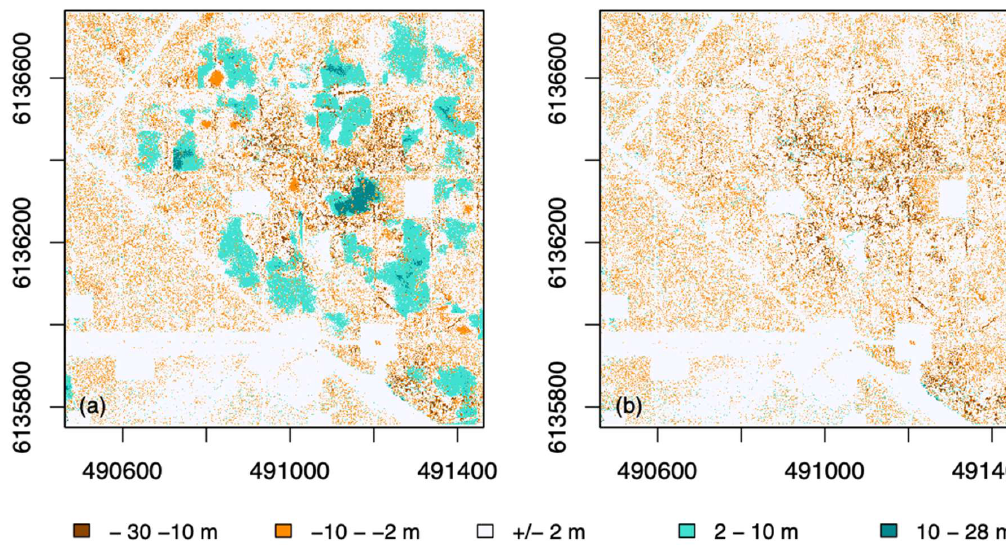
Figure 8. Differential images of: ( a ) CHM DAP and ( b ) CHM Hybrid , each compared to CHM LiDAR . (a) shows large clusters of high divergence from the CHM LiDAR , depicted in turquoise. These conglomerations are missing in (b), showing the improvement made possible by using a LiDAR-derived DTM.